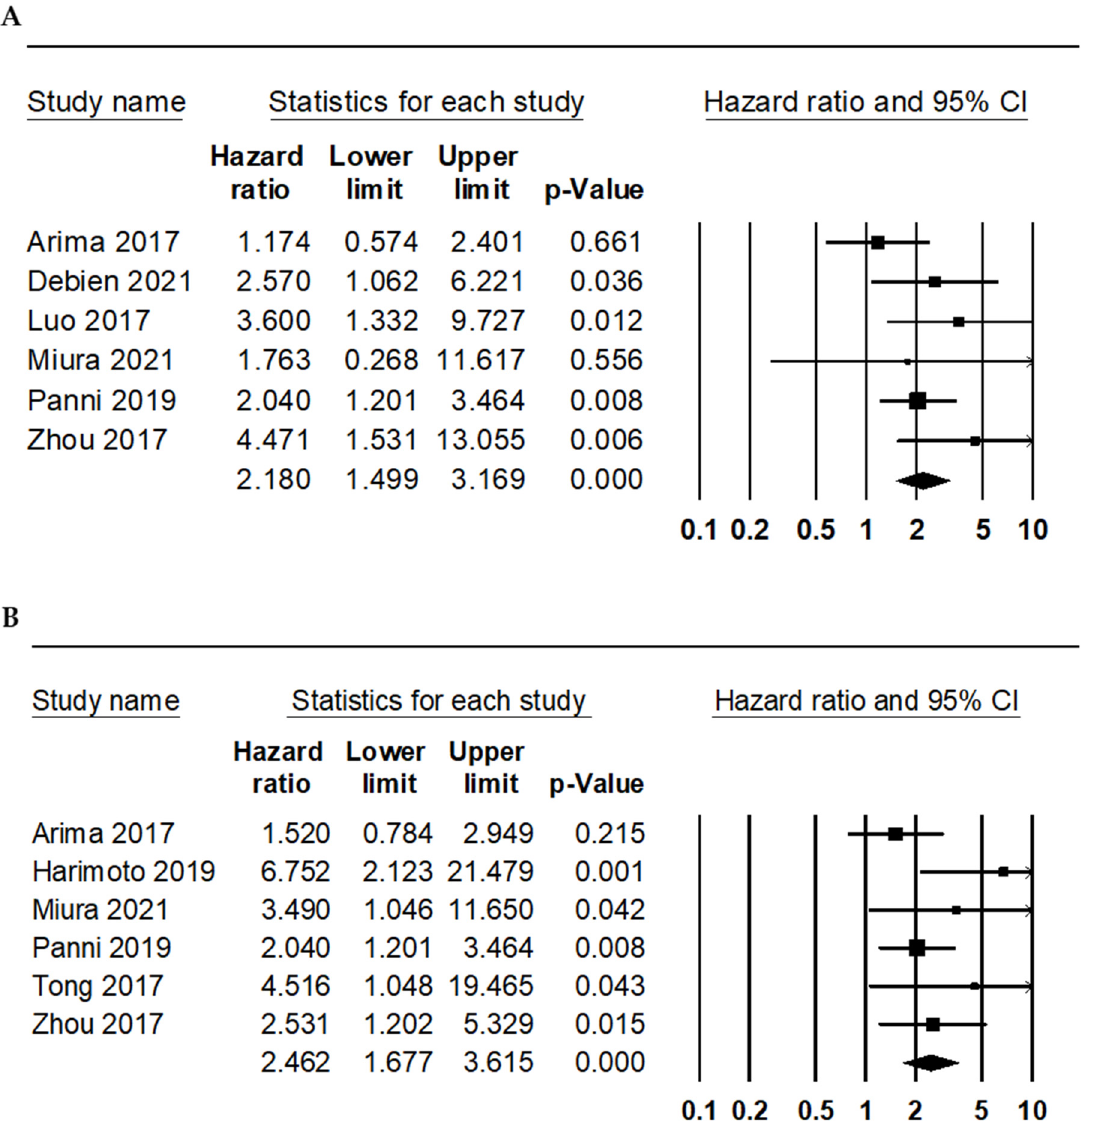
Figure 2. Forest plots for the correlations between a high neutrophil-to-lymphocyte ratio and worse survival rates. ( A ) Overall survival and ( B ) recurrence-free survival. Table 4. Correlation between the neutrophil-to-lymphocyte ratio (NLR) and survival rate according to the criteria of a high NLR.